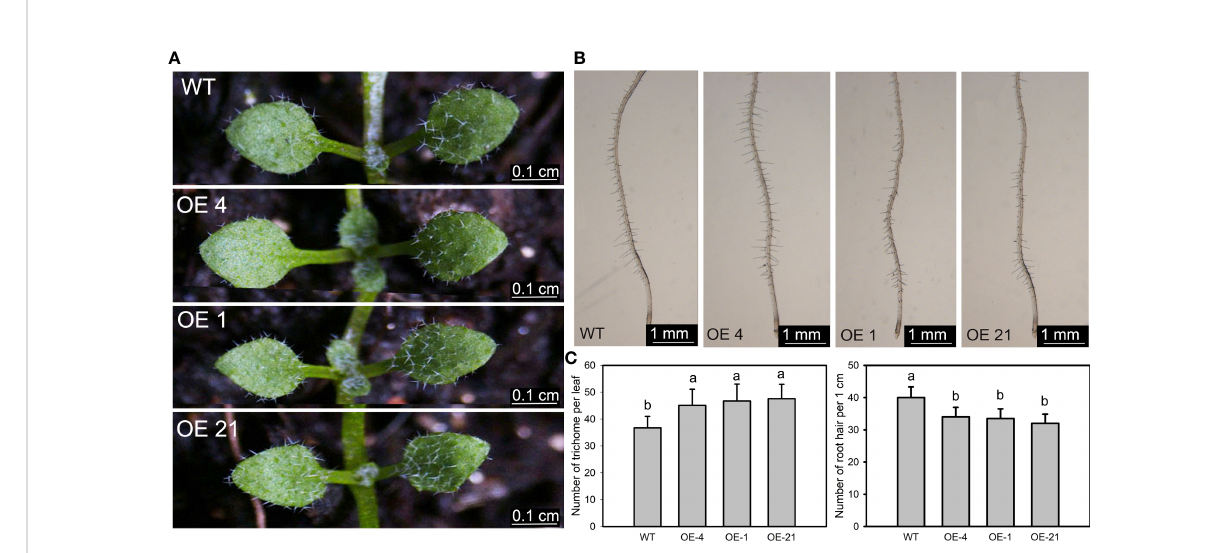
FIGURE 3 Trichome and root hair development in 35S : Lb1G04794 Arabidopsis lines. (A) Trichomes on the fi rst two rosette leaves of the non-transgenic wild-type (WT, Col-0) and 35S : Lb1G04794 (OE 4, OE 1, and OE 21). Photographs show seedlings grown on half-strength MS medium for 7 days. Scale bar, 0.1 cm. (B) Root hairs in seedlings grown for 5 days on half-strength MS medium. Scale bar, 1 mm. (C) Number of trichomes per leaf (leaf) and root hairs (right) in WT and 35S : Lb1G04794 lines. Trichome number was counted in 10 seedlings. Root hair number was counted in the same region of each root (1 cm from root tip upward) for 10 seedlings per line. Data are means ± SD of 10 seedlings; different lowercase letters indicate signi fi cant differences at P = 0.05 according to Duncan ’ s multiple range test.